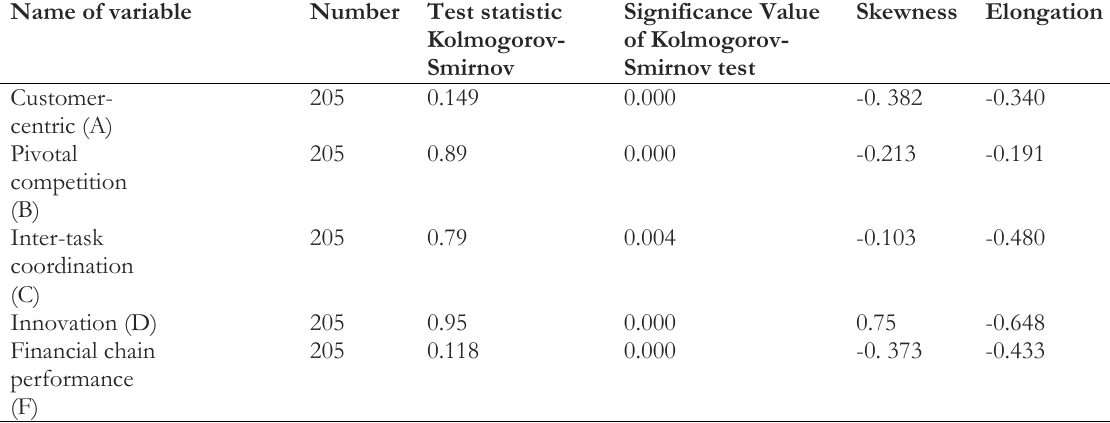
Table 4. Normality test results for research